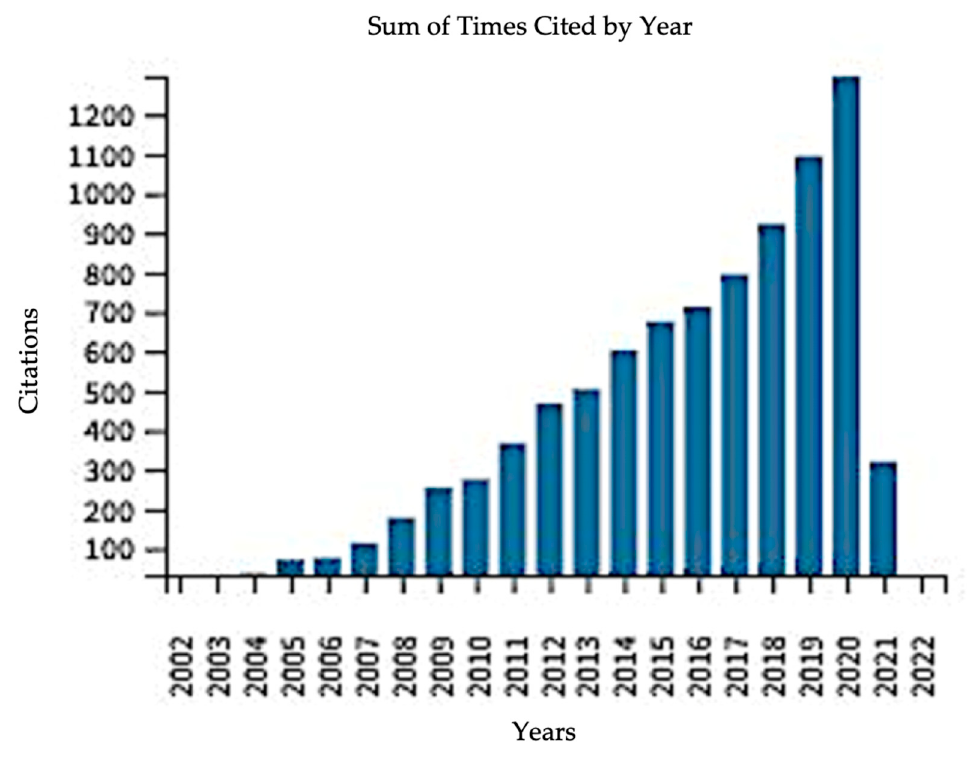
Figure 7. Citation report for 369 results from Web of Science Core Collection.